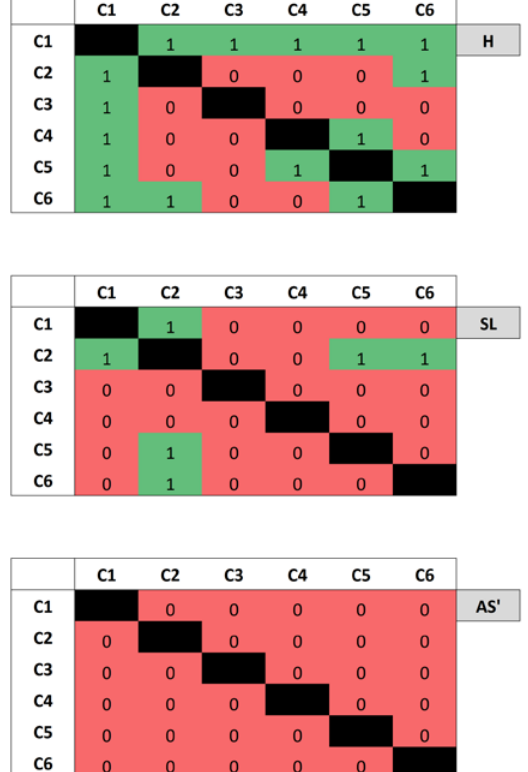
Figure 14. Significance of differences between the cluster mean values of H , SL , and AS ′ . Red and green cells show not significant and significant difference values.